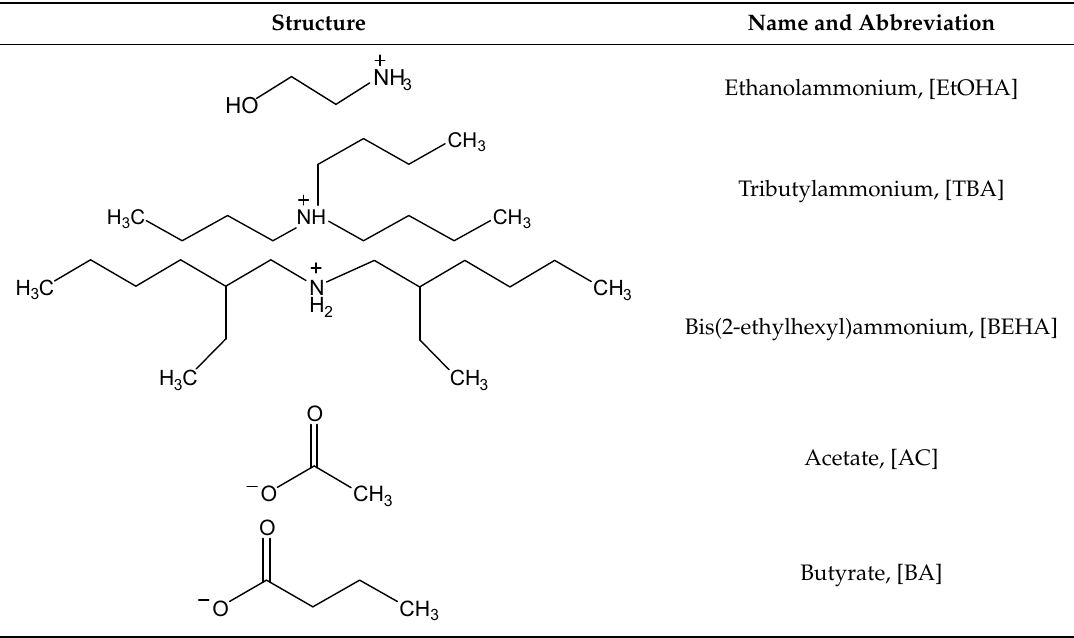
Table 1. Structures of cations and anions, names and abbreviations.